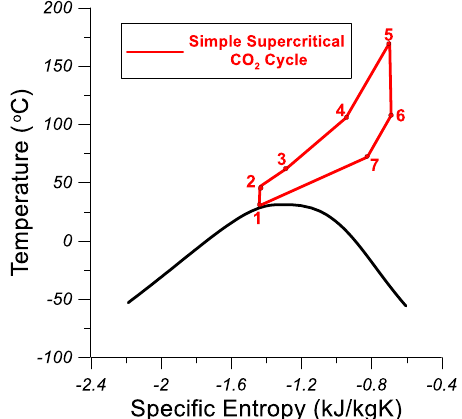
Figure 3. Representation of a simple supercritical CO 2 cycle at temperature – entropy (T-s).